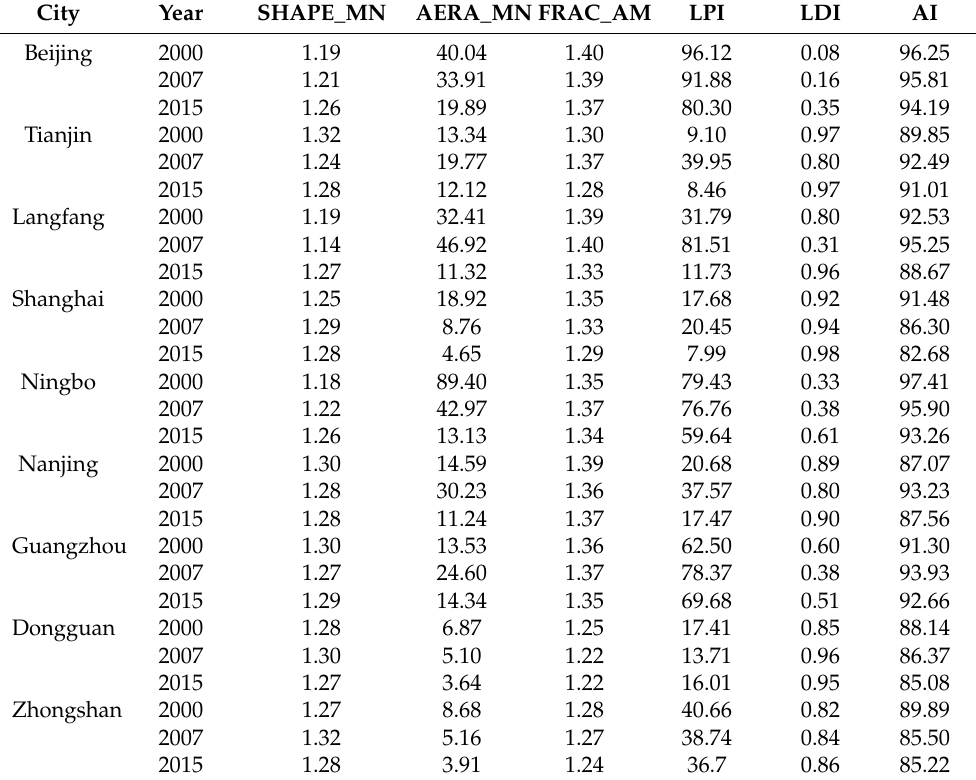
Table 3. The analysis results of the landscape configuration metrics of the urban green space for different urban sizes and levels considered in this